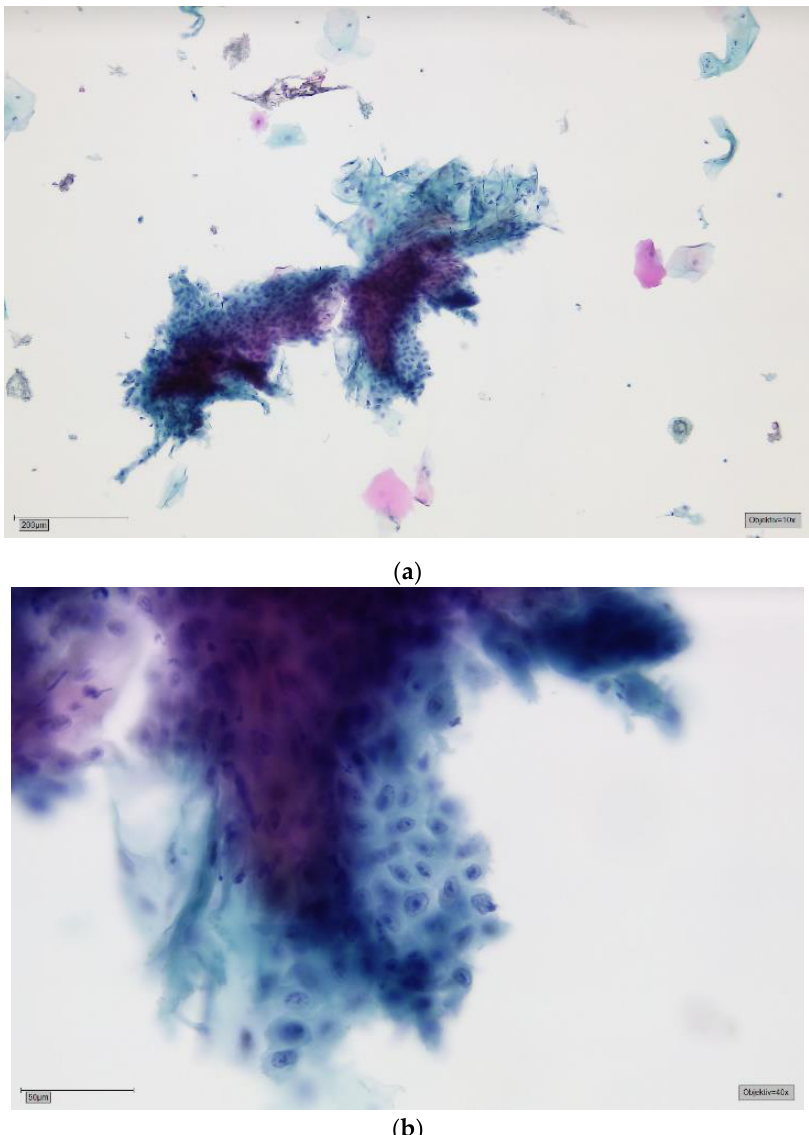
Figure 4. ( a ) Suspicious for tumour cells — SurePath, staining Papanicolaou, lens 10×. Clinically, an ulcerative lesion of the lateral border of the tongue. The background shows some amorphous deposits of partly eosinophilic, partly basophilic material, most obvious in the top central field. The big cell groups form partly sheets, partly three-dimensional crowds. Immaturity, a high nuclear/cytoplasmic (N/C) ratio and anisonucleosis can be suspected in this magnification. ( b ) Suspicious for tumour cells — detail, lens 40×. On high power there is marked anisonucleosis. The nuclei are haphazardly orientated, the axes of different nuclei are not parallel. Many nuclei show prominent nucleoli and/or irregularities of their borders. Chromatin is frequently irregularly deposited with early condensation along the nuclear membrane. These changes may represent so-called atypical tissue repair. The differential is high grade SIL or invasive SCC. The background may represent the ulcer or tumour diathesis. We would try to confirm the suspicion with DNA-karyometry. A scalpel biopsy must be performed for confirmation.